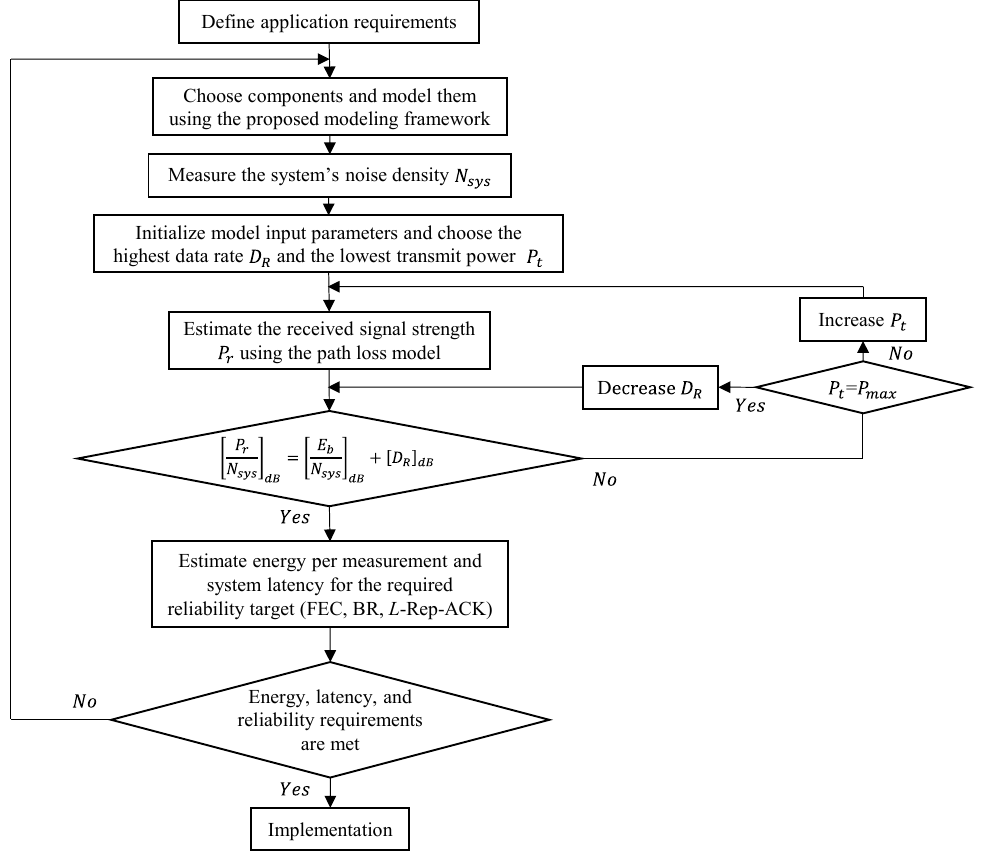
Figure 21. SN design flow graph.